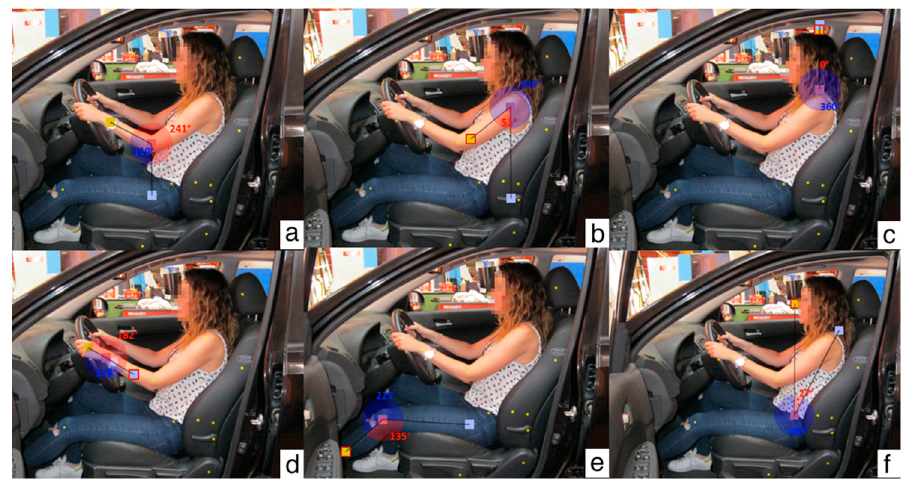
Figure 7. Examples of the limb angles of one volunteer. ( a ): Ankle, ( b ): Shoulder, ( c ): Neck, ( d ): Wrist, ( e ): Knee, ( f ): Trunk.